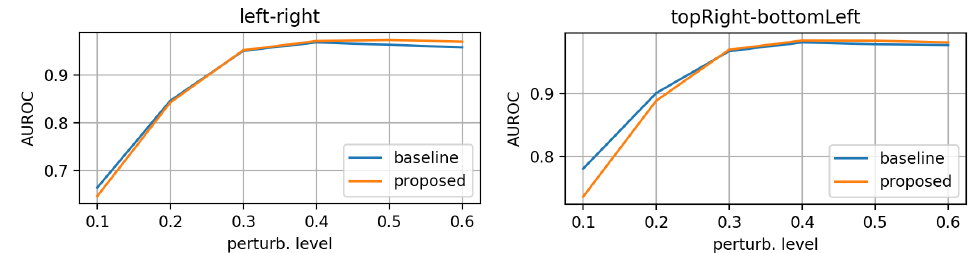
Figure 12. AuRoC performance for the baseline and proposed architecture when tested against mask morphing in various directions. Training done on augmented dataset using the hinge loss in Equation